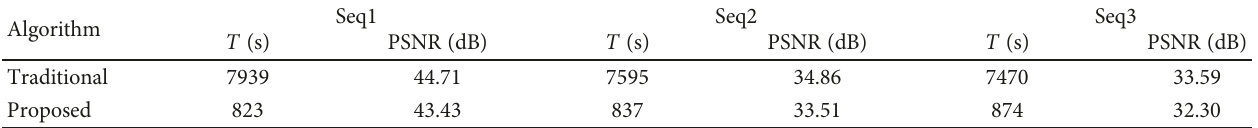
Table 1. After combination, domain and range blocks of Seq1, Seq2, and Seq3 are divided into 20, 15, and 15 cat- egories, respectively. The comparison of performance of the three methods is shown in Table 4, where PSNR is the mean of 4 frames.